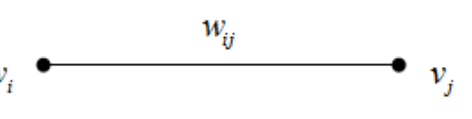
Figure 12. Model of a